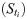
Global sensitivity analysis for models (1)–(3).Here we show the total-order sensitivity indices (Sti) we obtained from global sensitivity analysis exploring the space of parameters through 10000 samples for each model (up to 125000 simulations for model (1)). We achieved a reliability indicator of 99.7% for model (1), 99.9% for model (2), and 99.8% for model (3). It is noticeable that most of the variance can be linked to three of the parameters for the three models, i.e., those three parameters mostly determine the behavior of the models. Besides, the ranking of relevance of the parameters is almost the same for the models.